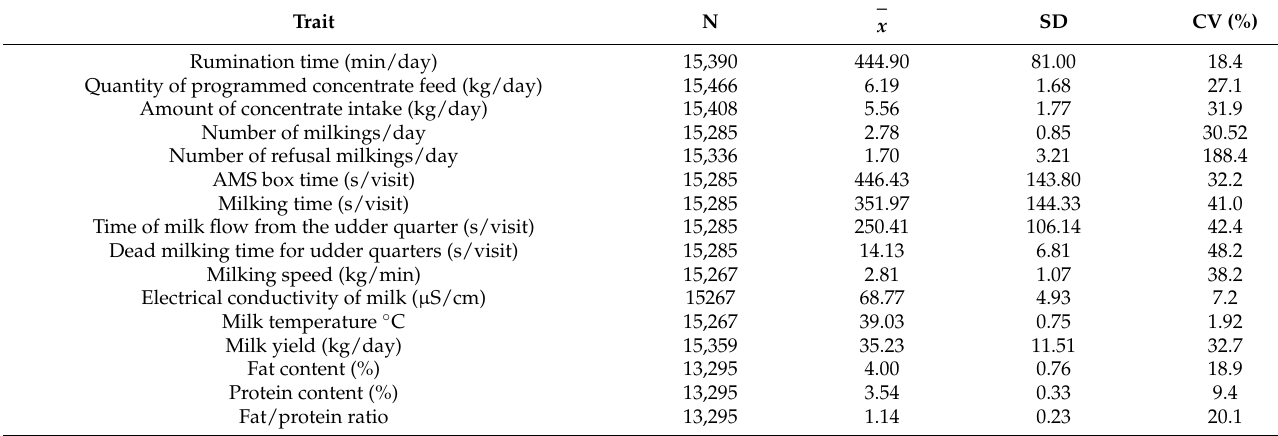
Table 3. Descriptive statistics of rumination, milking parameters and milk traits in the period from 5 to 28 days of lactation. Trait N ¯ x SD CV (%) Rumination time